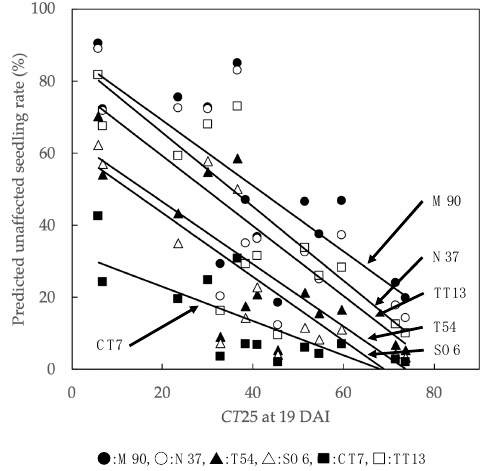
Figure 6. Relationship between optimum temperature factor and predicted unaffected seedling rate. The predicted unaffected seedling calculated from a generalized linear mixed model including optimum temperature factor ( CT 25 at 19 DAI). DAI: days after inoculation. Family name abbreviations: Misaki 90 (M90), Namikata 37 (N37), Tanabe 54 (T54), Shizuoka (Oosuka) 6 (SO6), Chiba (Tomiura) 7 (CT7), and Tottori (Tottori) 13